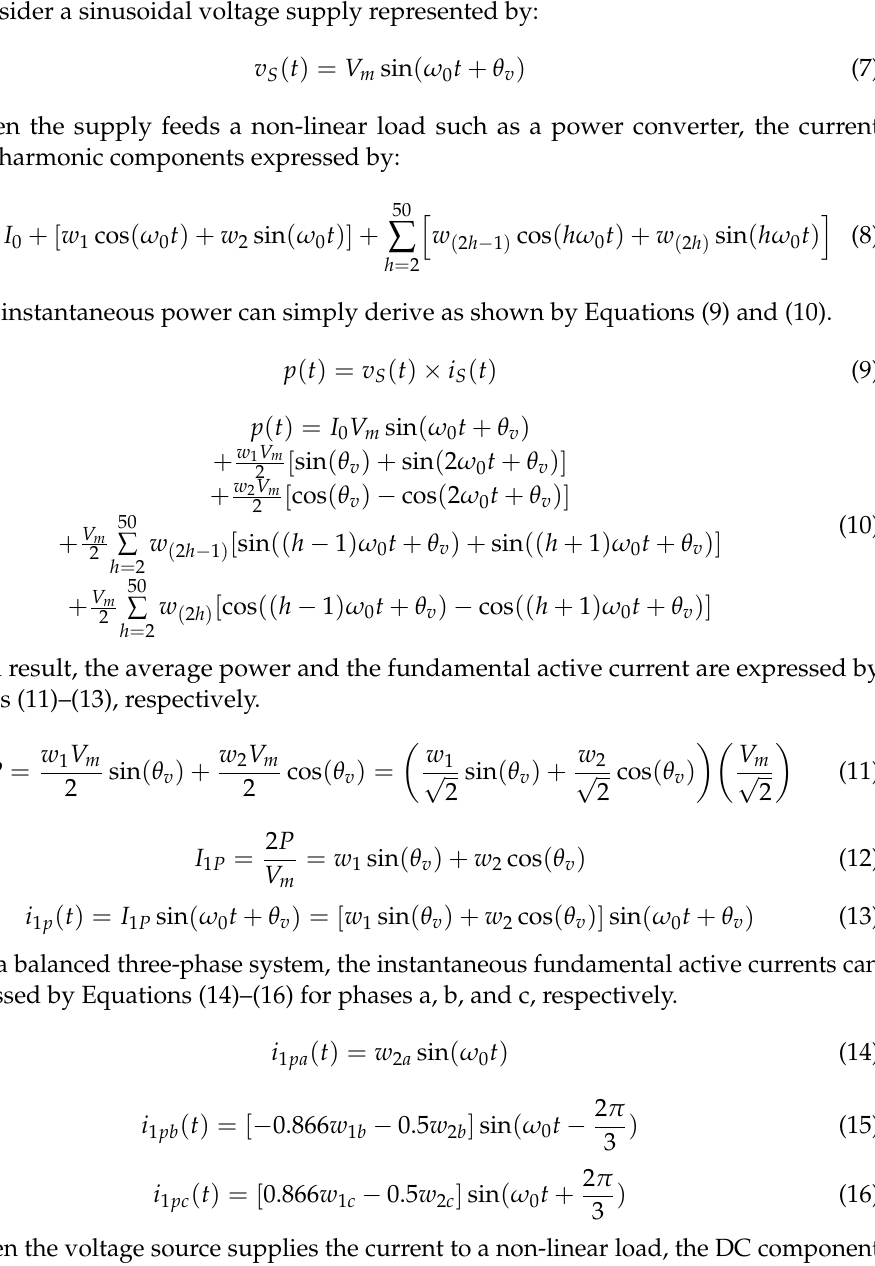
Figure 3. ADALINE harmonic extraction.